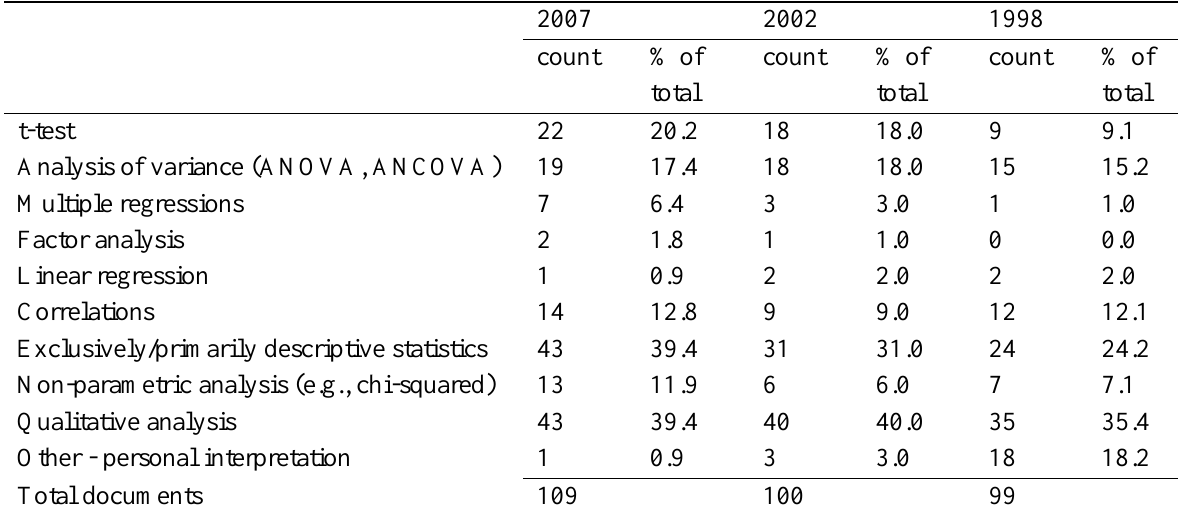
Table 6 Data Analysis Technique Distribution by